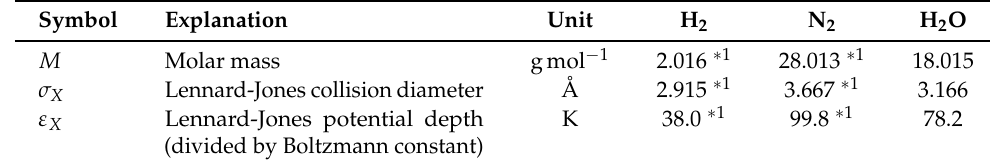
Table A4. Gas properties: values marked by * 1 are from Ref.